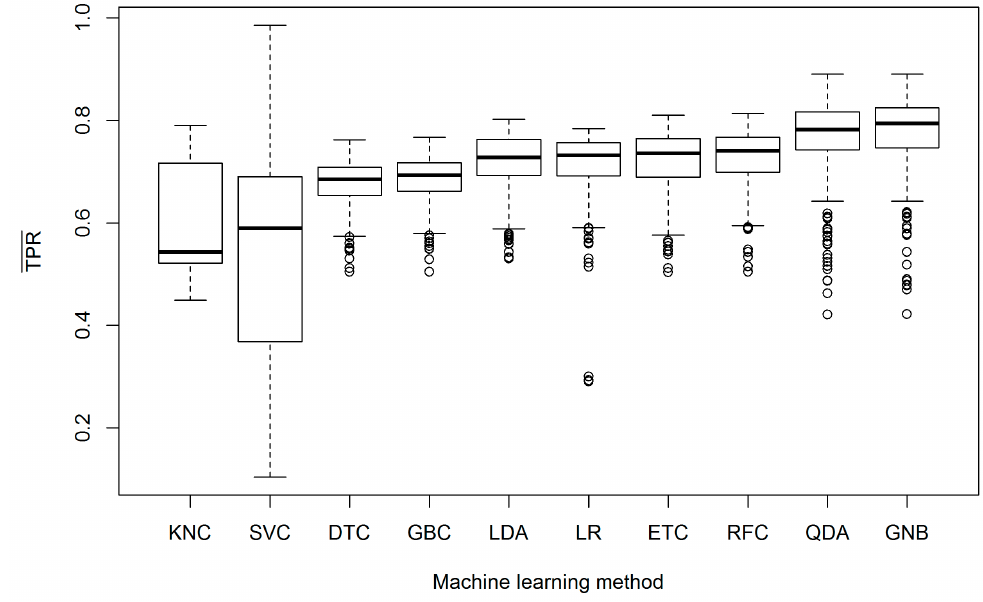
Figure 6. Box plots of mean sensitivities ( TPR ) of FDMs generated by MLAs. Box plots show median plus upper and lower quartiles for mean sensitivities of all FDMs generated by a given algorithm. Minimum and maximum values are indicated by the upper and lower whiskers (1.5 × interquartile range). Circles are outliers. See Table 3 for MLA codes.